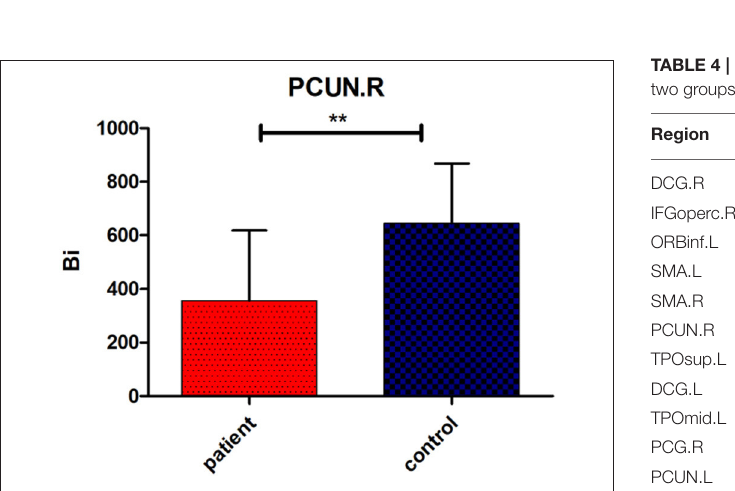
FIGURE 3 | Significant group difference in betweenness centrality value (Bi) of right precuneus (PCUN.R). Bars and error bars indicate the mean and standard deviation. The asterisk marks indicates a significant difference between the two groups ( p < 0.05; false discovery rate corrected).